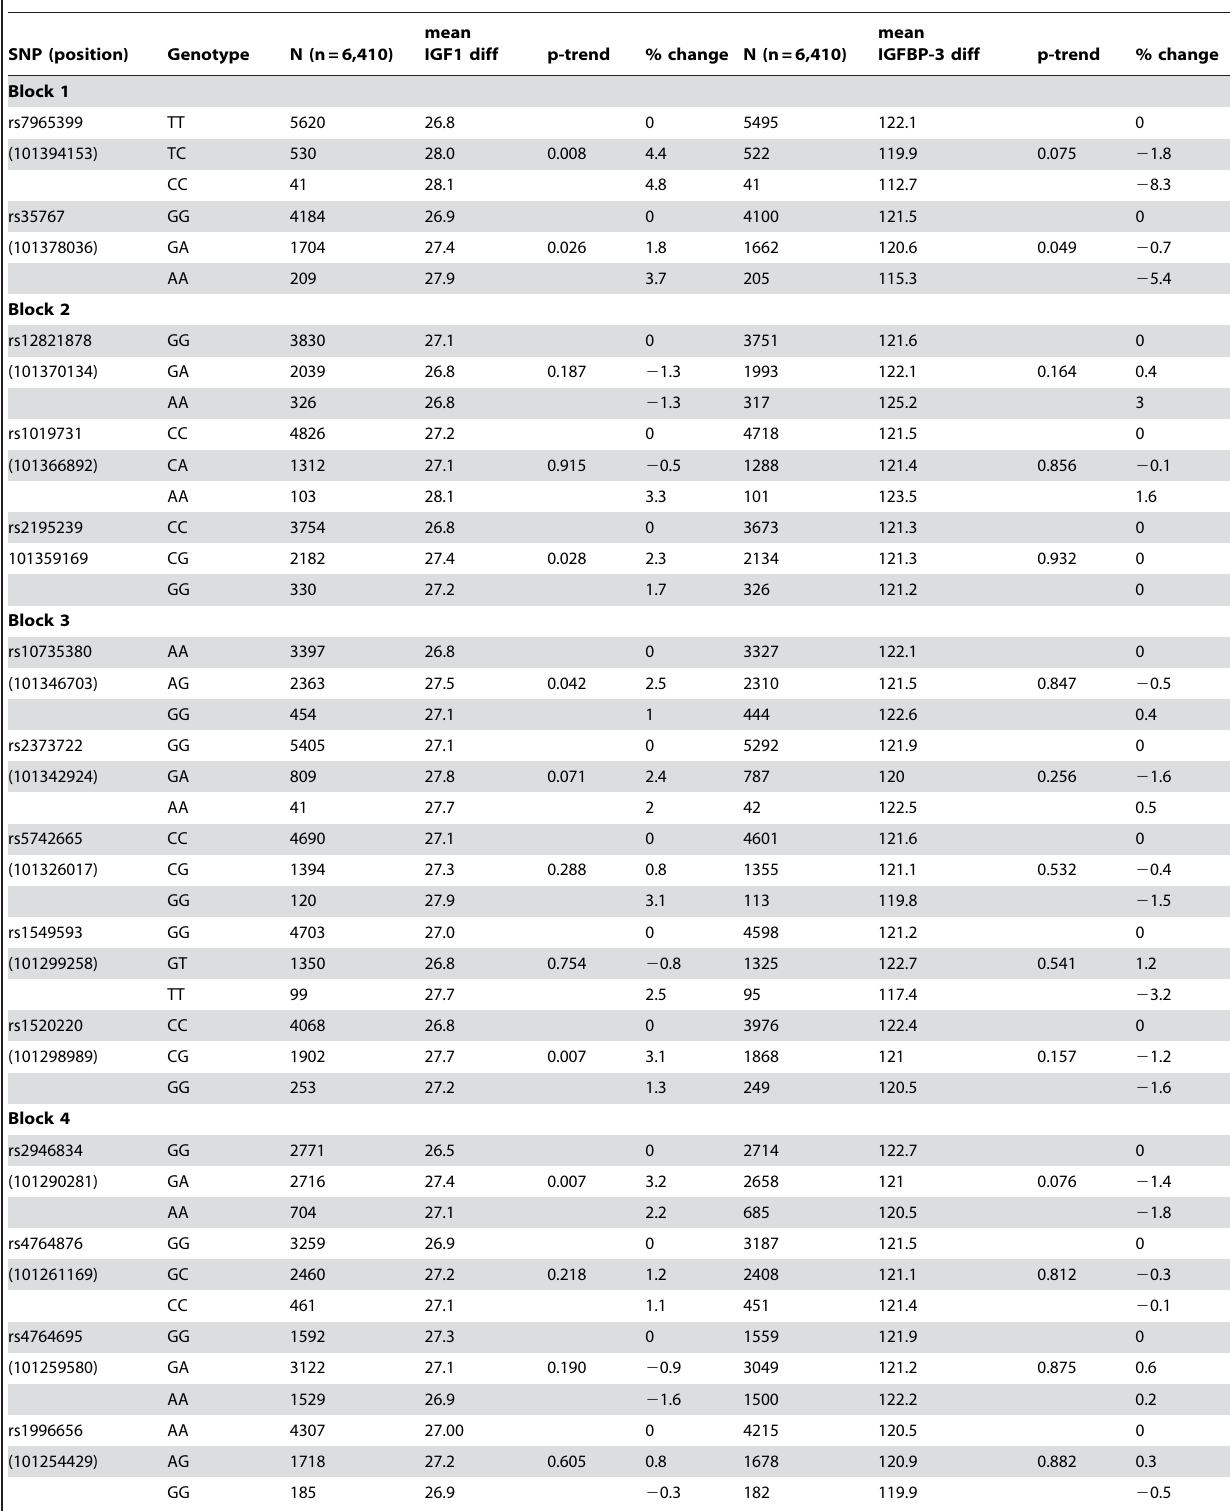
Table 1. Associations between IGF1 SNPs and mean circulating IGF-I and IGFBP-3 levels in the BPC3.